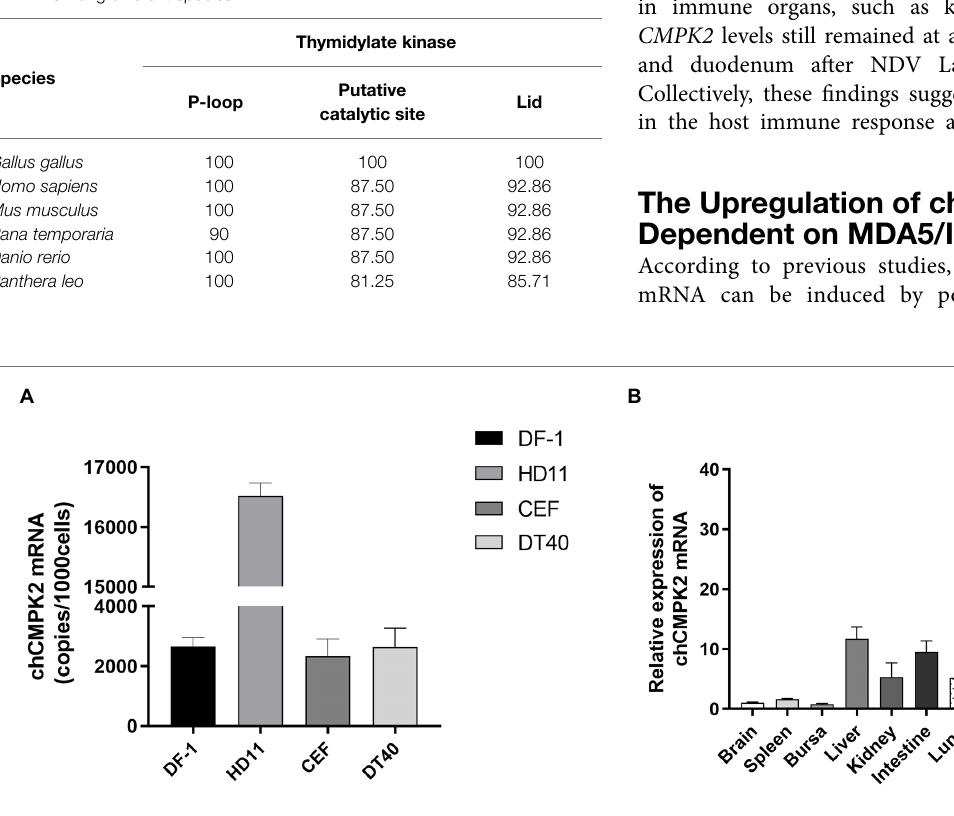
FIGURE 3 | Distribution of chCMPK2 in different cells and chicken tissues. (A) DF-1 cells, HD11 cells, CEFs, and DT40 cells were seeded in 12-well plates until 90% confluence. The absolute quantification PCR was performed to detect CMPK2 mRNA in all cell lines. CMPK2 mRNA levels were showed by calculating copies per 1,000 cells (copies/1,000 cells). (B) CMPK2 mRNA levels were measured in tissues (brain, spleen, bursa, liver, kidney, intestine, lung, heart, thymus, and duodenum) of SPF